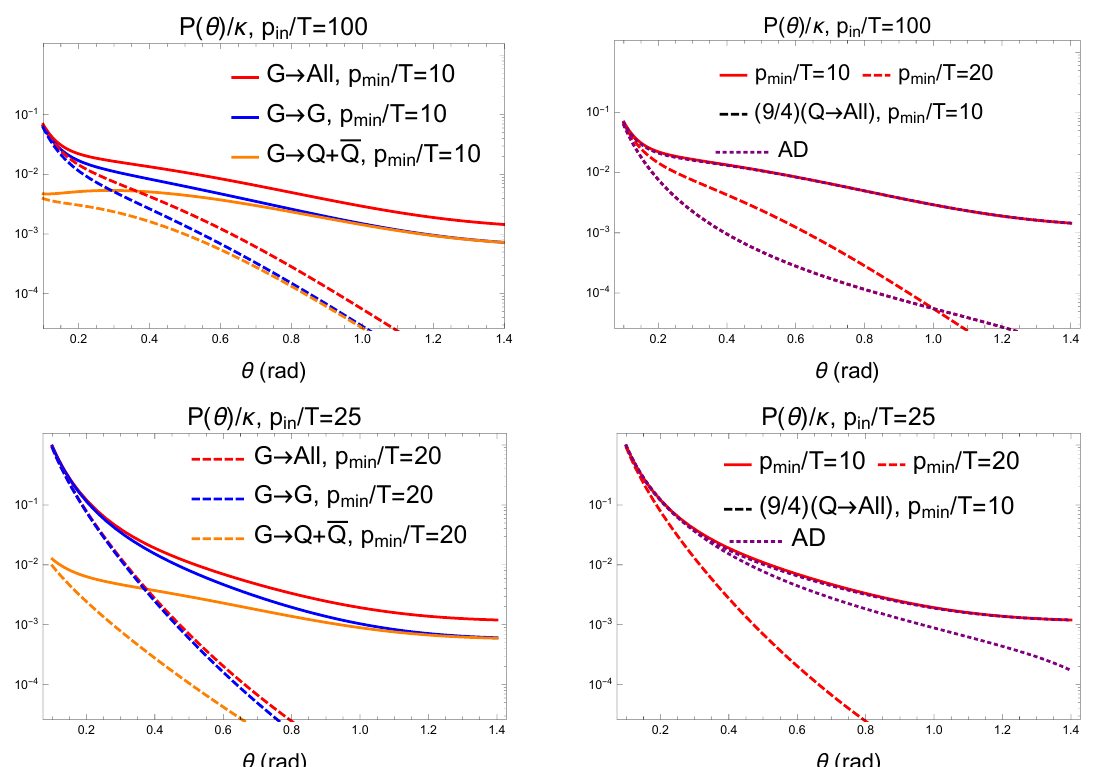
Figure 4 . The probability distribution P ( (cid:18) ) divided by (cid:20) for an incident gluon with p in =T = 100 (upper row) and p in =T = 25 (lower row). In the two panels in the left column, the solid curves correspond to choosing p min , the lower limit on the integration over p in eq. (1.3), to take the value p min =T = 10 while the dashed curves correspond to choosing p min =T = 20. In addition to plotting the probability distribution for (cid:12)nding any outgoing parton at a given (cid:18) as the red curves, we also present its breakdown into the cases of an outgoing gluon (blue curves) and an outgoing quark or antiquark (orange curves). In the right column, we plot P ( (cid:18) ) for an incident gluon (red) as well as for an incident quark times 9 = 4 (black dashed curves) as well as the (cid:18) (cid:28) 1 result P AD ( (cid:18) ) from eq. (3.4) (cid:12)rst obtained by Arnold and Dogan